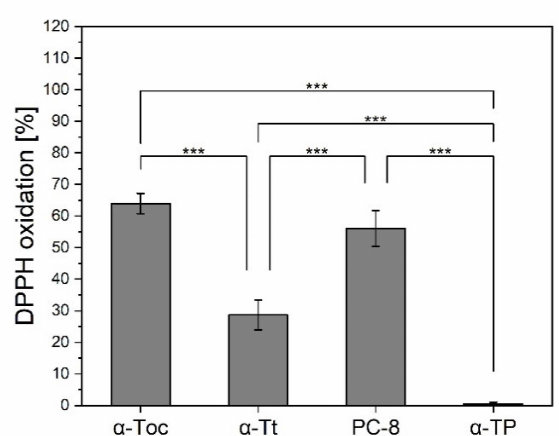
Figure 8. DPPH radical scavenging activity of α -Toc, α -Tt, α -TP, and PC-8 incorporated into niosomes. The data are means SEM ( n = 3). Asterisks indicate statistically significant differences (*** p < 0.001; ± one-way ANOVA followed by Tukey’s post hoc